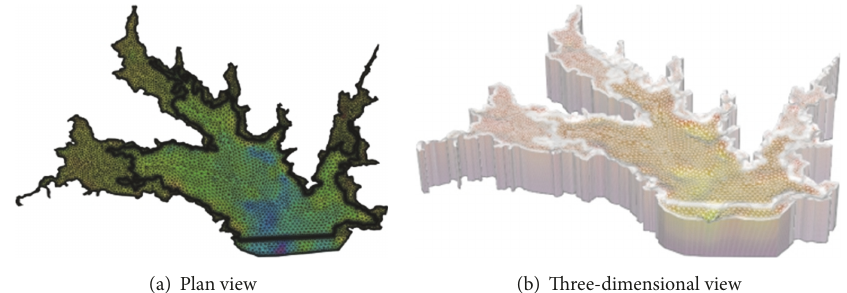
Figure 6: Meshing graph of study area based on a numerical method.